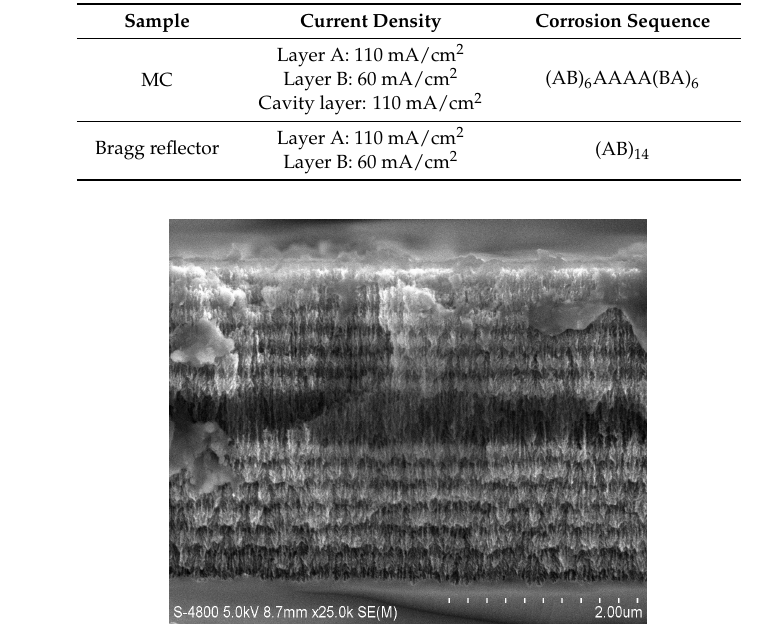
Figure 2. The cross-section image of PSiMC.